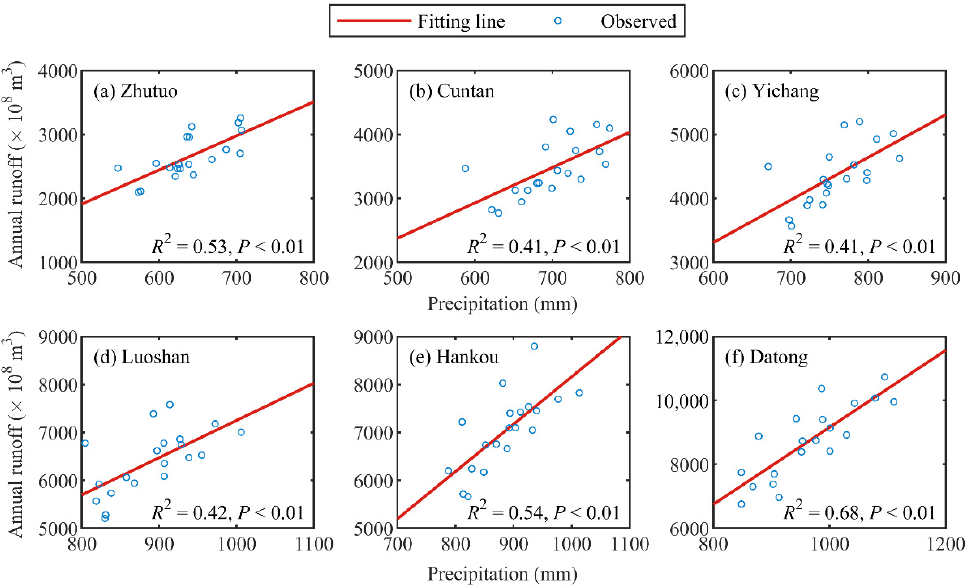
Figure 6. Relationships between annual runoff and precipitation from the natural period.